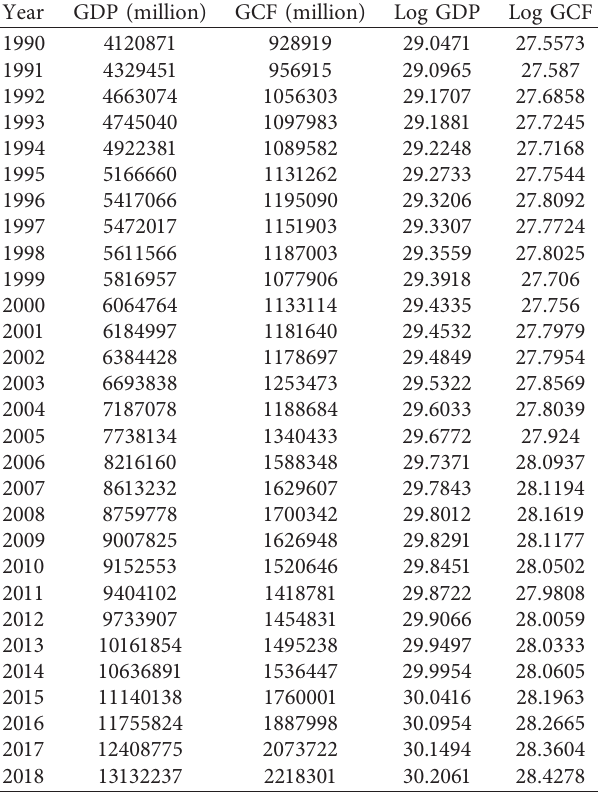
The monetary figure of millions represents Pakistani